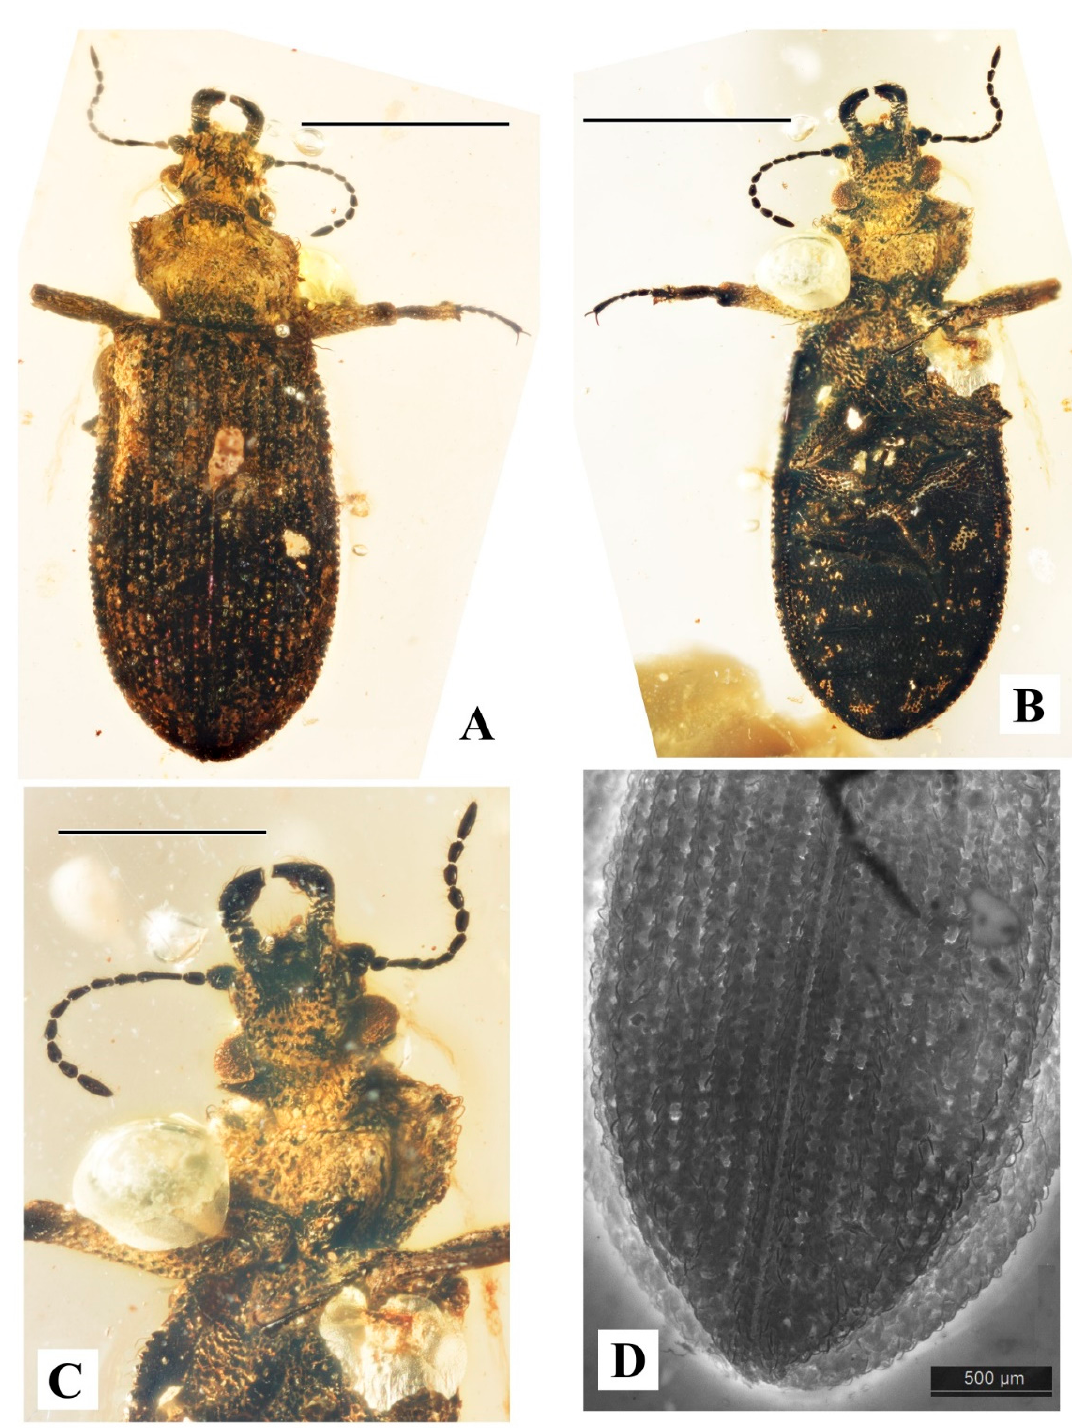
Figure 9. Ommatinae (Cupedidae): Clessidromma zengi sp. nov. , holotype ZIN Cuped 003 (Lower / Upper Cretaceous: Upper Albian / Lower Cenomanian; Myanmar, Kachin, Burmese amber): A —beetle, dorsal, B —same, ventral, C —anterior part of body, ventral; D —elytra, dorsal (fluorescent microscopy with filter set L5); length of inclusion 6.2 mm of, scale bar for A and B = 2.0 mm, scale bar for C = 1.0 mm, scale for D shown with indication mm; original.